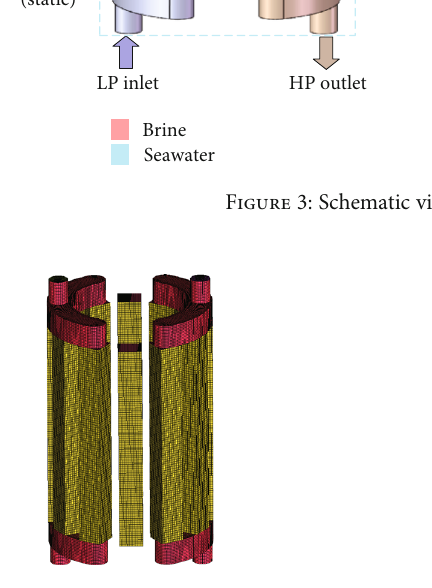
Figure 4: Computational mesh.